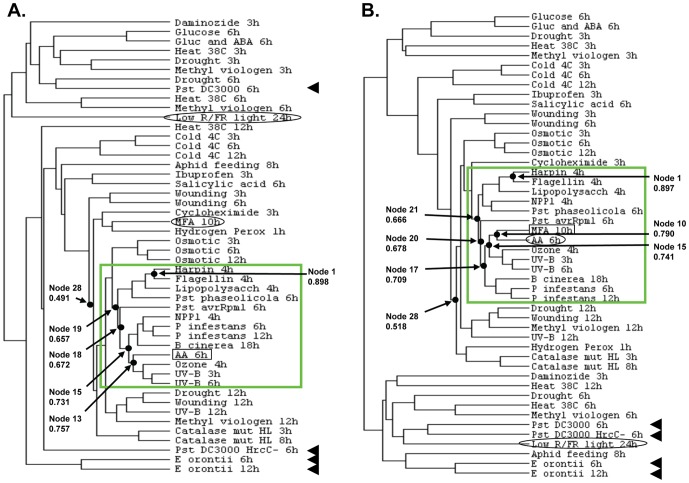
Relationship between AA, MFA, and other stress treatments based on cluster analyses.From public data bases, 46 experiments were chosen that used treatments of leaves or seedlings, and Affymetrix ATH1 arrays. The expression patterns of nuclear genes that were statistically significantly (q≤0.05) altered in expression by AA (a) or that were significantly altered in expression by MFA (b) were compared to their expression patterns in the transcriptomes resulting from the 46 stress treatments (Resource S5) and from the other inhibitor treatment. Their expression ratios in treatment versus control were compared with those from AA or MFA treatment using Cluster (Hierarchical Clustering/Average Linkage Clustering). The resulting array clusters were visualized using TreeView. The query gene set (i.e., transcriptome) for each inhibitor is indicated by a box in a and b, while the non-query inhibitor gene set is circled. A photomorphogenesis experiment transcript subset that served as an outgroup is circled in a and b. Pathogen and pathogen-related treatments clustering near AA and MFA are delimited by a green box; pathogen treatments elsewhere in the tree are designated with arrow heads to the right. Correlation coefficients for the tree nodes (Resource S6) range, left to right, in a. from −0.112 to 0.898 and in b. from −0.105 to 0.897. Numbers of designated nodes and their correlation coefficients are shown in the figures.